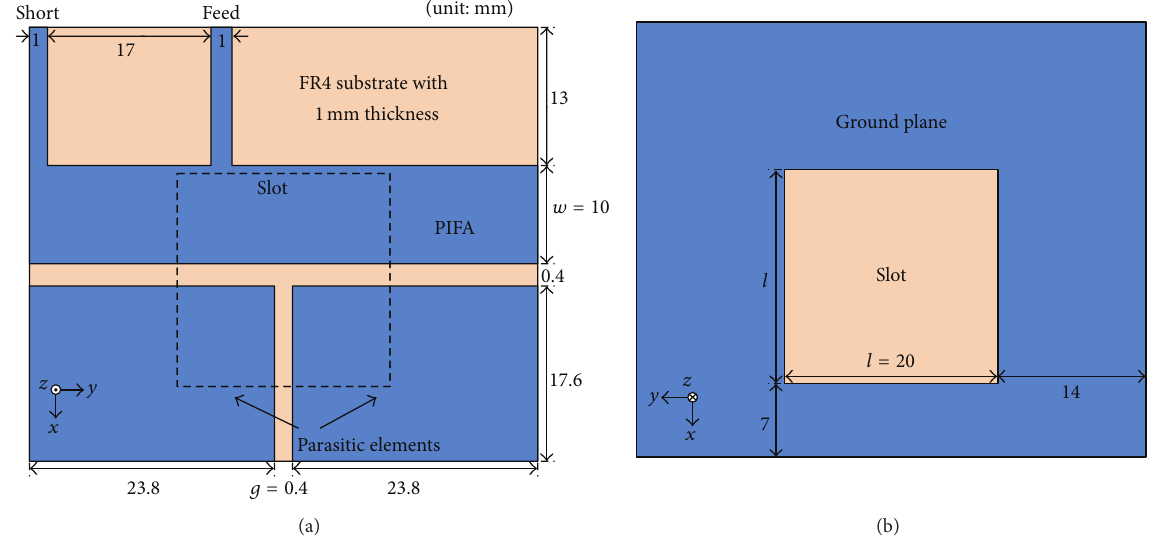
Figure 1: Configuration of the proposed antenna: (a) top view and (b) bottom view.